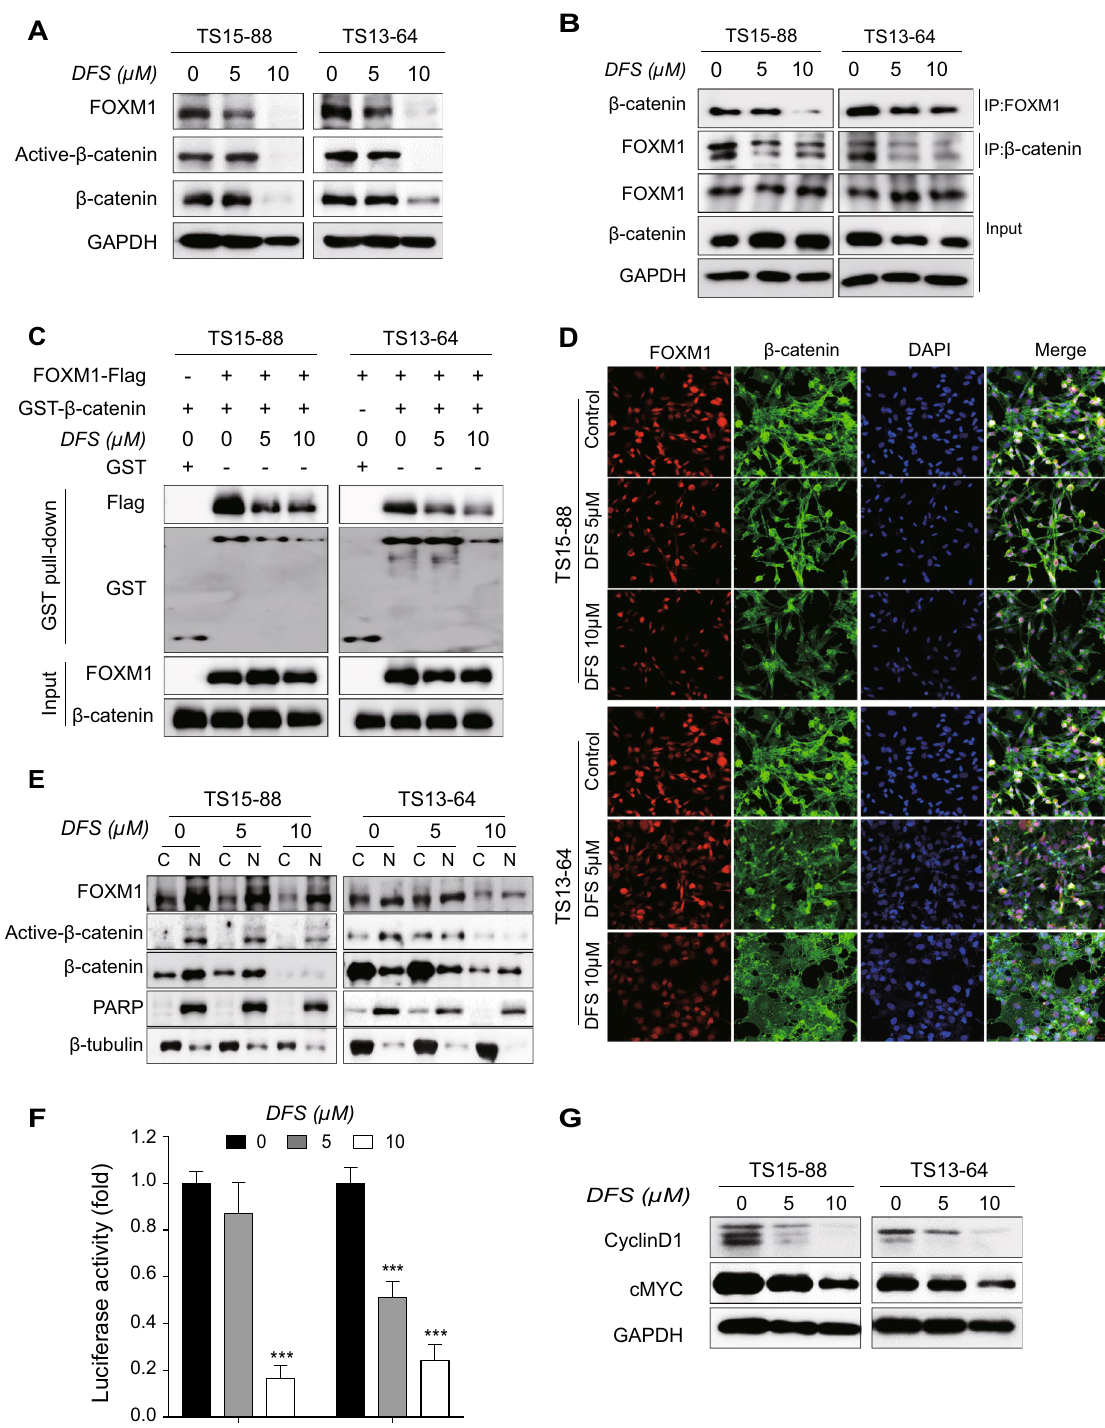
Figure 3. Inhibition of FOXM1/ β-catenin interaction by DFS. ( A ) GBM TSs were treated with DFS for 72 h and the protein levels of FOXM1, active-β-catenin and total β-catenin were determined by western blotting. ( B ) DFS-treated GBM TSs were immunoprecipitated with anti-FOXM1 and β-catenin antibody, and endogenous expression of FOXM1 and β-catenin proteins were determined by western blotting to determine interactions between them. ( C ) GST pull- down assay to confirm whether FOXM1 and β-catenin interactions are direct or indirect. ( D ) Immunofluorescence to determine whether DFS affects the nuclear translocation of β-catenin (magnification × 20). ( E ) Levels of FOXM1 and β-catenin proteins in the cytosolic and nuclear fractions of GBM TSs determined by western blotting. The cytosolic and nuclear fractions are denoted by C and N, respectively. Cytosolic marker: β-tubulin; nuclear marker: PARP. ( F ) Measurements of β-catenin/TCF signaling activity in GBM TSs transfected with TOPflash or FOPflash luciferase vector. ( G ) Expression of proteins encoded by β-catenin downstream genes (cyclin D1, cMYC) measured by western blotting. Differences among groups were compared by one-way ANOVA with Tukey’s post hoc test; means ± SD; *P < 0.05, **P < 0.01, ***P < 0.001, between indicated groups or compared with